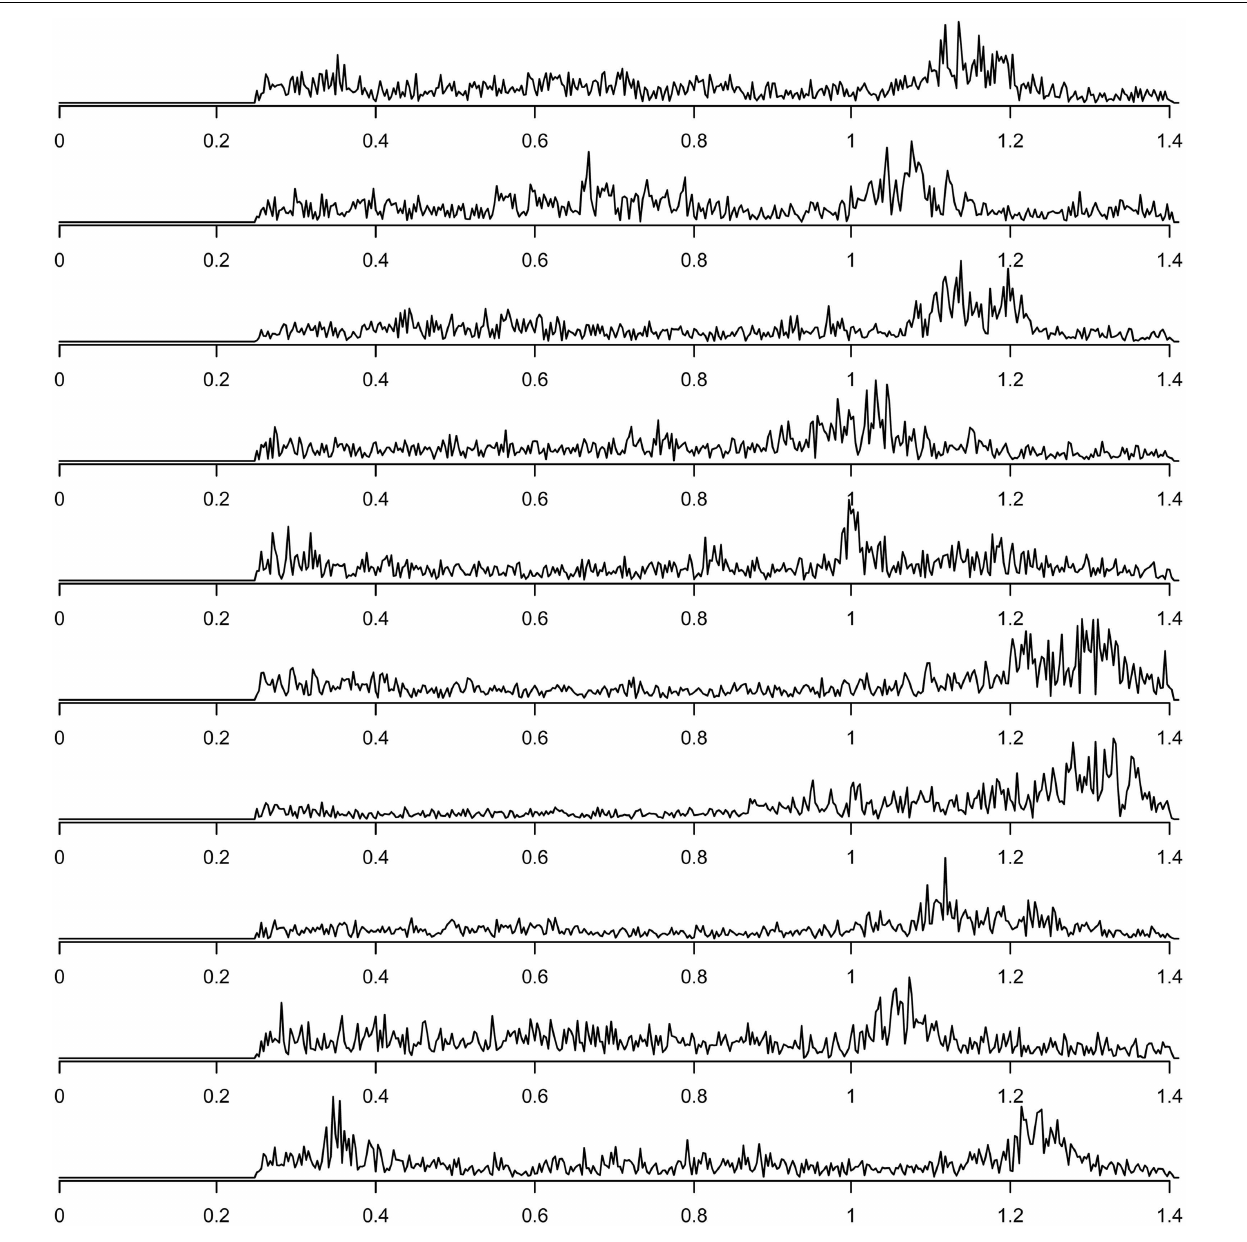
FIGURE 7 | Frequency spectra of components attributed to heart-beat (with peaks in the frequency range around 1–1.3Hz), one component for each of the 10 subjects